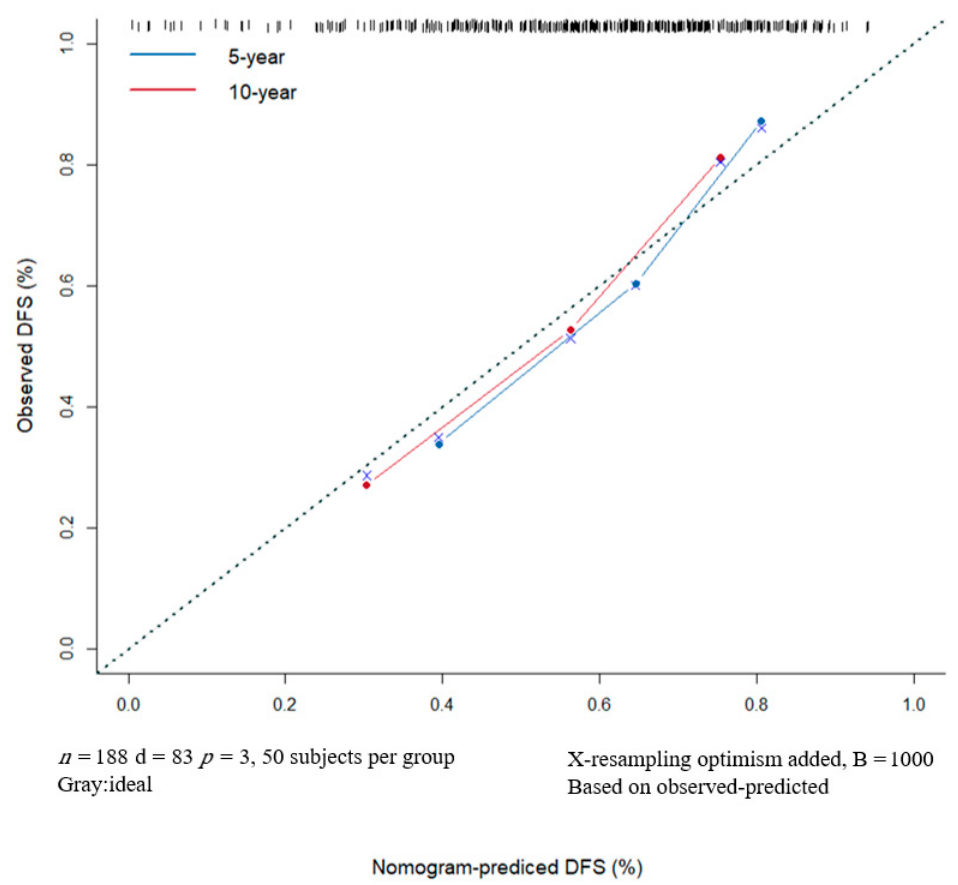
Figure 7. The DFS of 5- and 10-years predicted by the nomogram agrees with the actual observation. Nomogram Model Calibration Curve of 5- and 10-year Disease-free Survival. DFS, disease-free